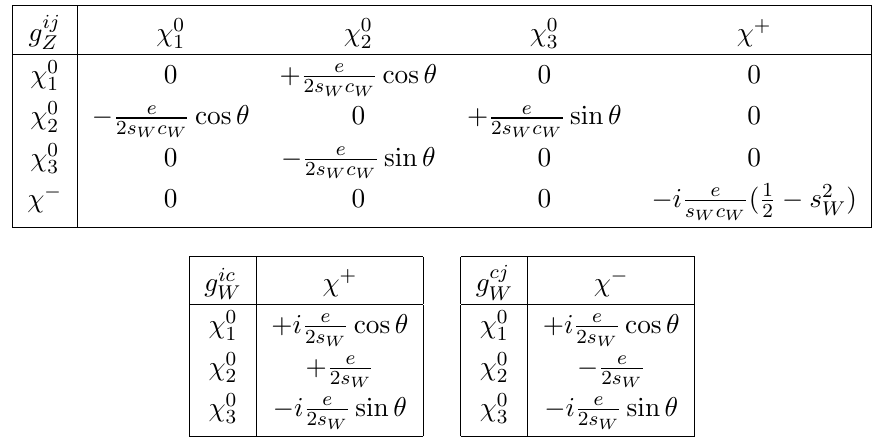
Table 1 . Coupling strength of vector-like Weyl fermions to weak gauge bosons in our dark fermion model. Here g ij denotes the coupling of boson V = W; Z to an incoming fermion in mass eigenstate V i = 1 ; 2 ; 3 ; c and an outgoing fermion in mass eigenstate j = f g